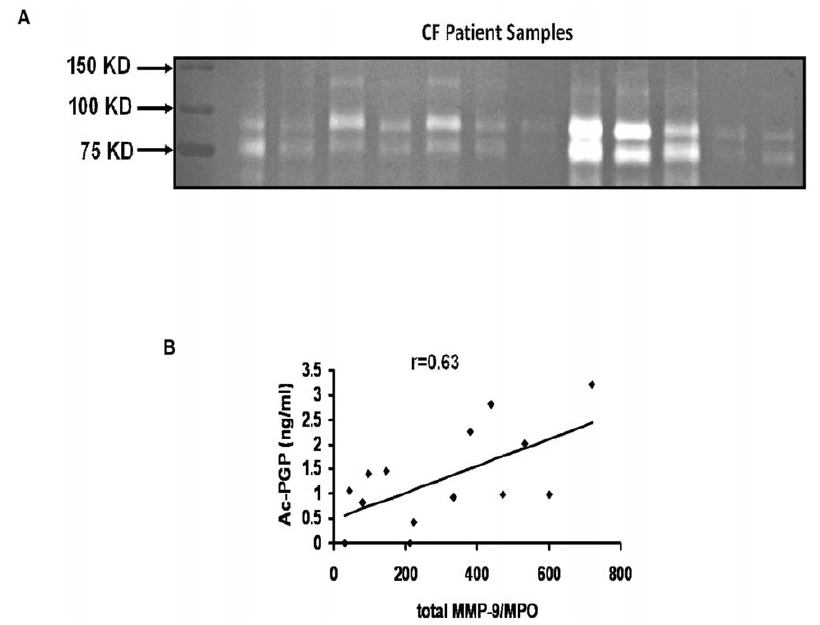
Figure 5. Ac-PGP correlated to the MMP-9/MPO ratio in CF patients. CF ( n= 14) sputum samples were collected to determine gelatinolytic activity by g elatin zymography (each lane represents an individual patient) ( A ) and for the measurement of Ac-PGP, MPO and MMP-9, and correlation analysis was conducted between Ac-PGP and MMP-9/MPO ratio ( B ). The CF sputum samples demonstrated a correlation coefficient ( r ) of 0.63